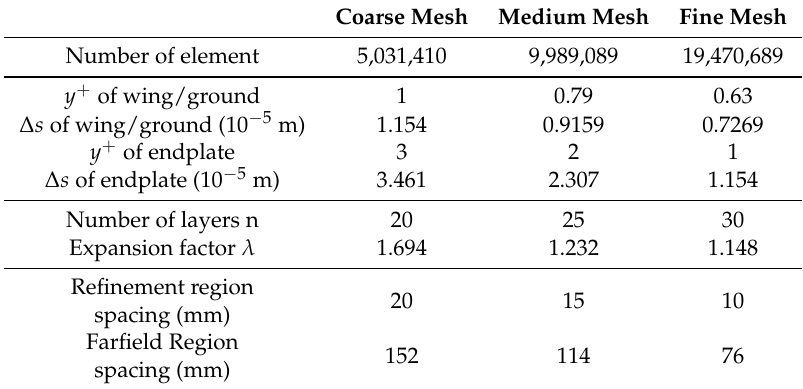
Table 2. Recapitulated table of all parameters used for mesh